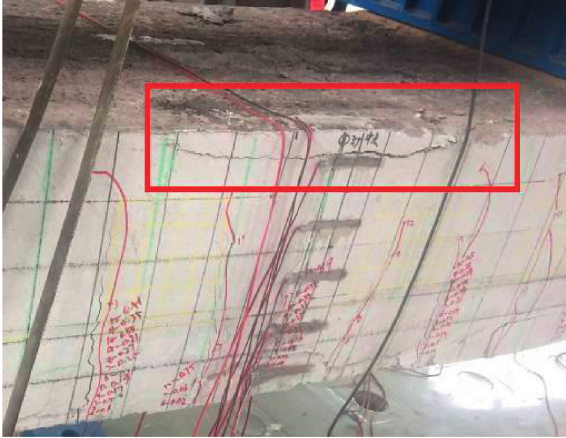
Figure 8: The failure of JD2: crushed